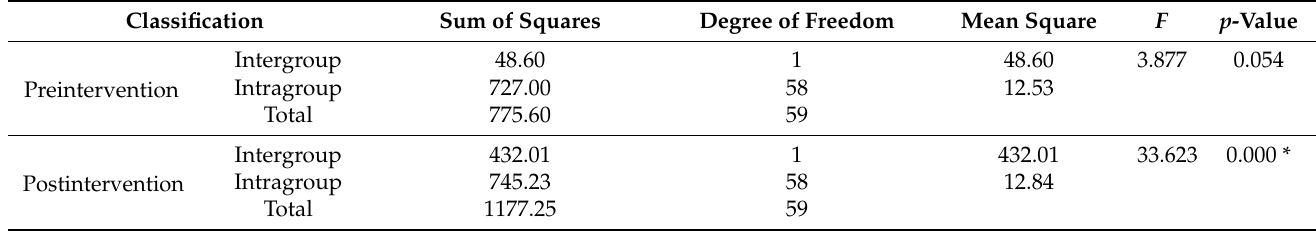
Table 4. Results of analysis of variance between pre-/post-group.